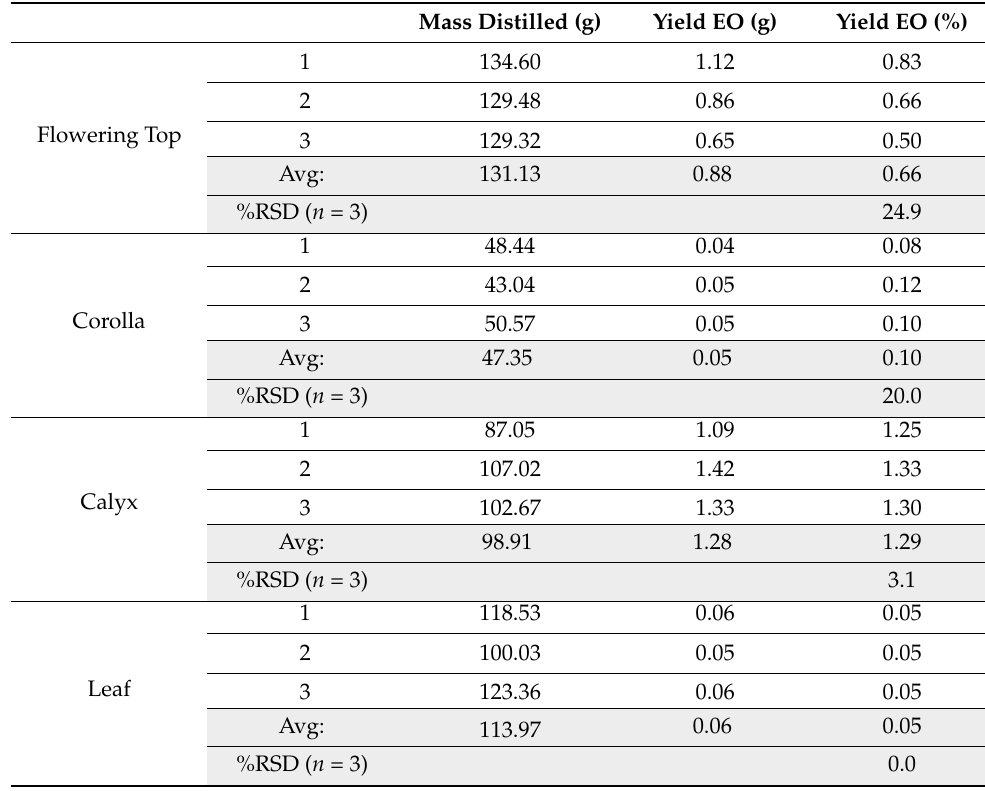
Table 2. Distribution of mass and essential oil (EO) yield averaged from lavender